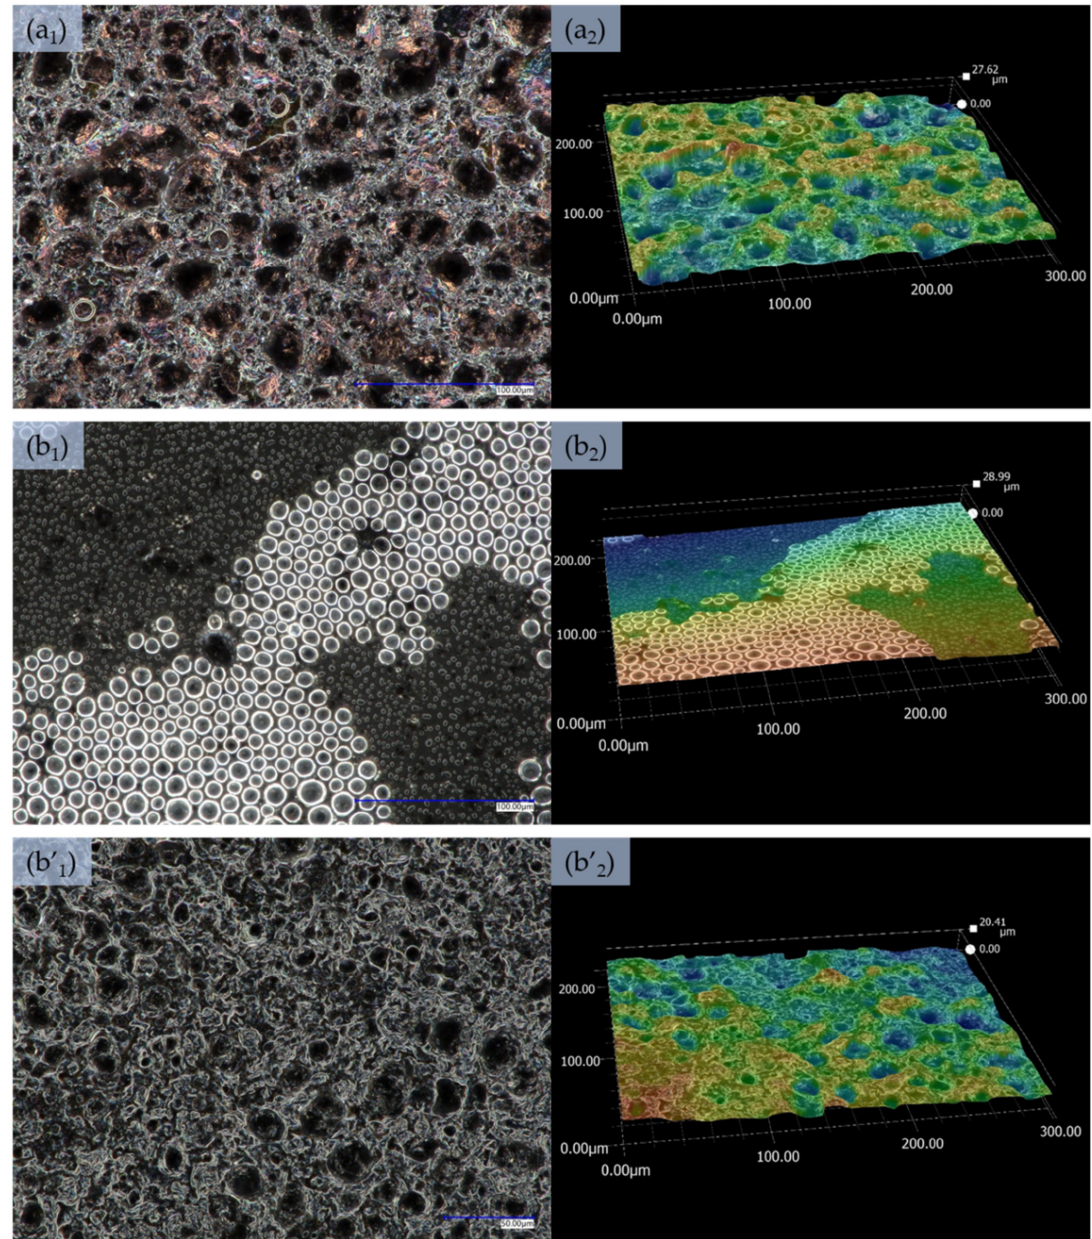
Figure 3. Images from an optical microscope presenting the morphology of films (mag × 1000) produced by drop-casting, and the depth profile presenting the roughness of the layers (mag × 1000): ( a 1 , a 2 )—D 4 dispersion, ( b 1 , b 2 , b’ 1 , b’ 2 )—D 7 dispersion in two different